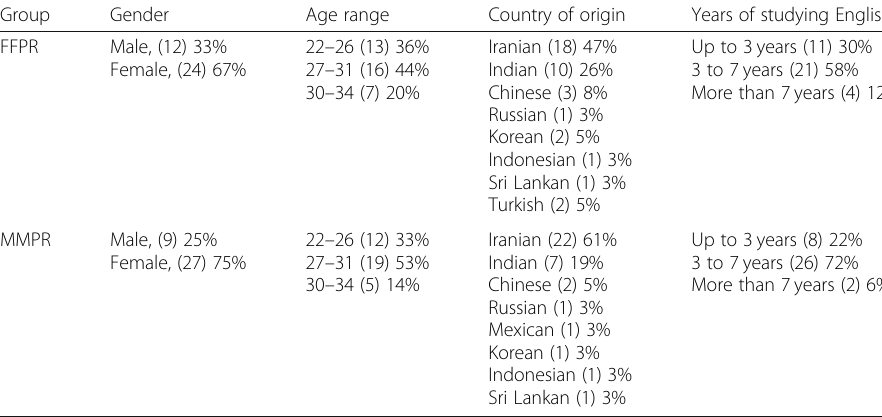
Table 1 Demographic information of participants